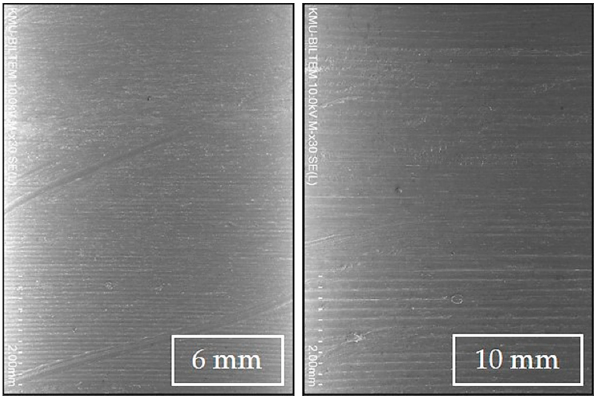
Figure 6. Borehole condition under SEM at 2000 rpm and 0.08 mm/rev.